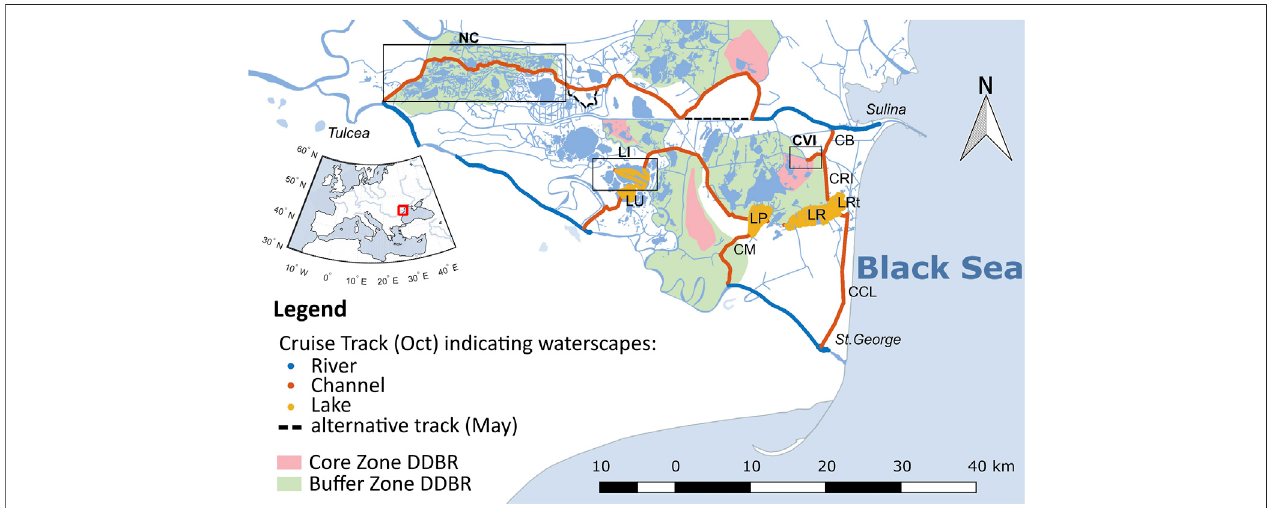
FIGURE1| SouthernpartoftheDanubeDeltawithcruisetracksofthesamplingcampaigninOctober2017.Colorsindicatethedifferentwaterscapes(blue=river, orange = channel, yellow = lake). The black dotted line indicates where the sampling track in May 2017 differed from October 2017. Red and green areas show the location of core and buffer zones of the Danube Delta Biosphere Reserve (Gastescu, 2013). Boxes indicate speci fi cally discussed sites: NC, northern channels, LI, Lake Isac, CVI, Canal Vatafu-Imputita. Other abbreviations stand for LU, Lake Uzlina ( Lake Isaccel ), LP, Lake Puiu, LR, Lake Rosu, LRt, Lake Rosulet, CM, Canal Mocanului ( Canal Mocansca ), CB, Canal Busurca, CRI, Canal Rosu-Imputita, CCL, Canal Cordon Litoral ( Canal Tataru ). Names refer to (Gastescu, 2013), italic names indicate deviating names on maps.google.ch. For mapping details see Methods section.